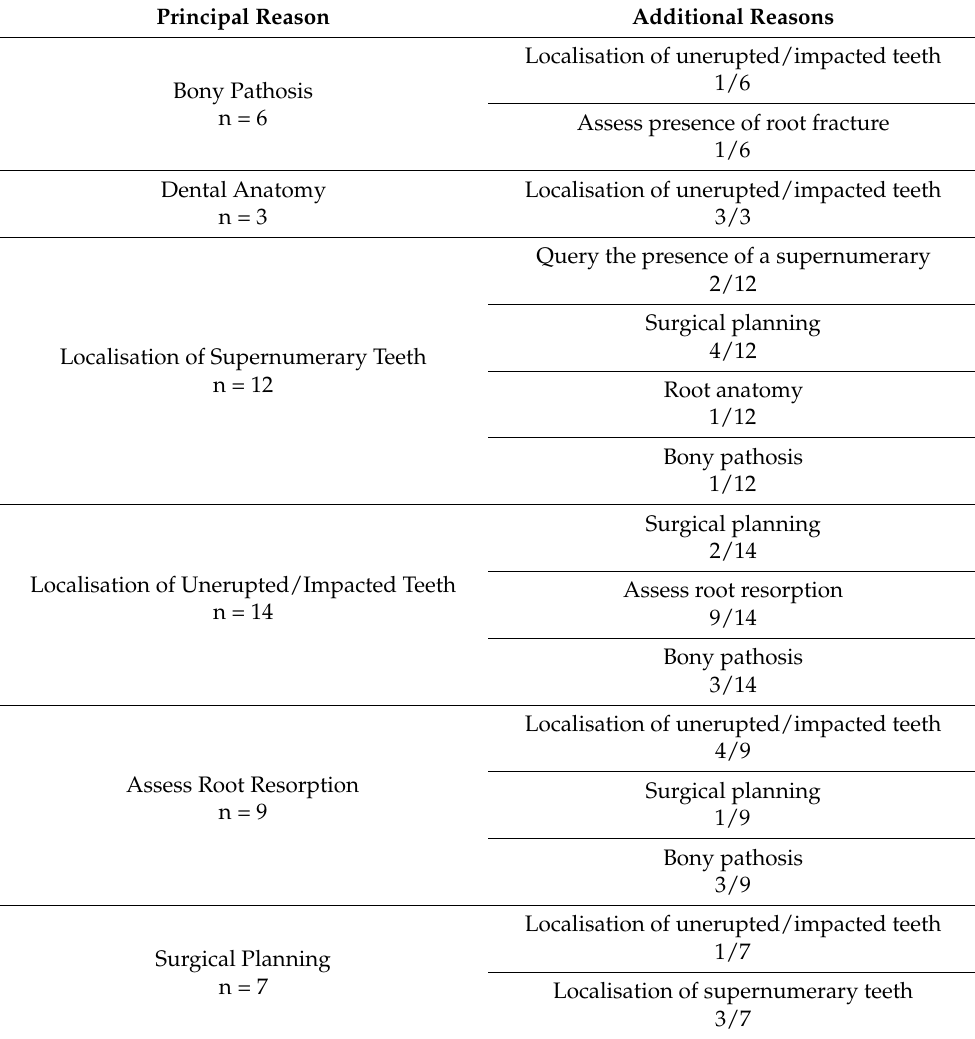
Table 4. Table showing the principal and additional reasons for requesting a CBCT in the paediatric